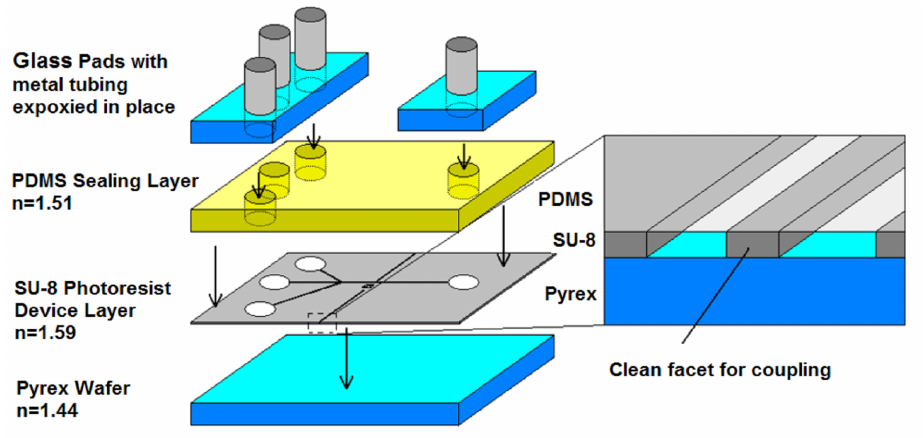
Figure 10. A schematic diagram showing the integration of a multilayered PDMS/SU-8 device. SU-8 is the functional layer; PDMS covers and seals the device; and glass pads allow solid fluidic interconnects. Reproduced from [65] with permission.